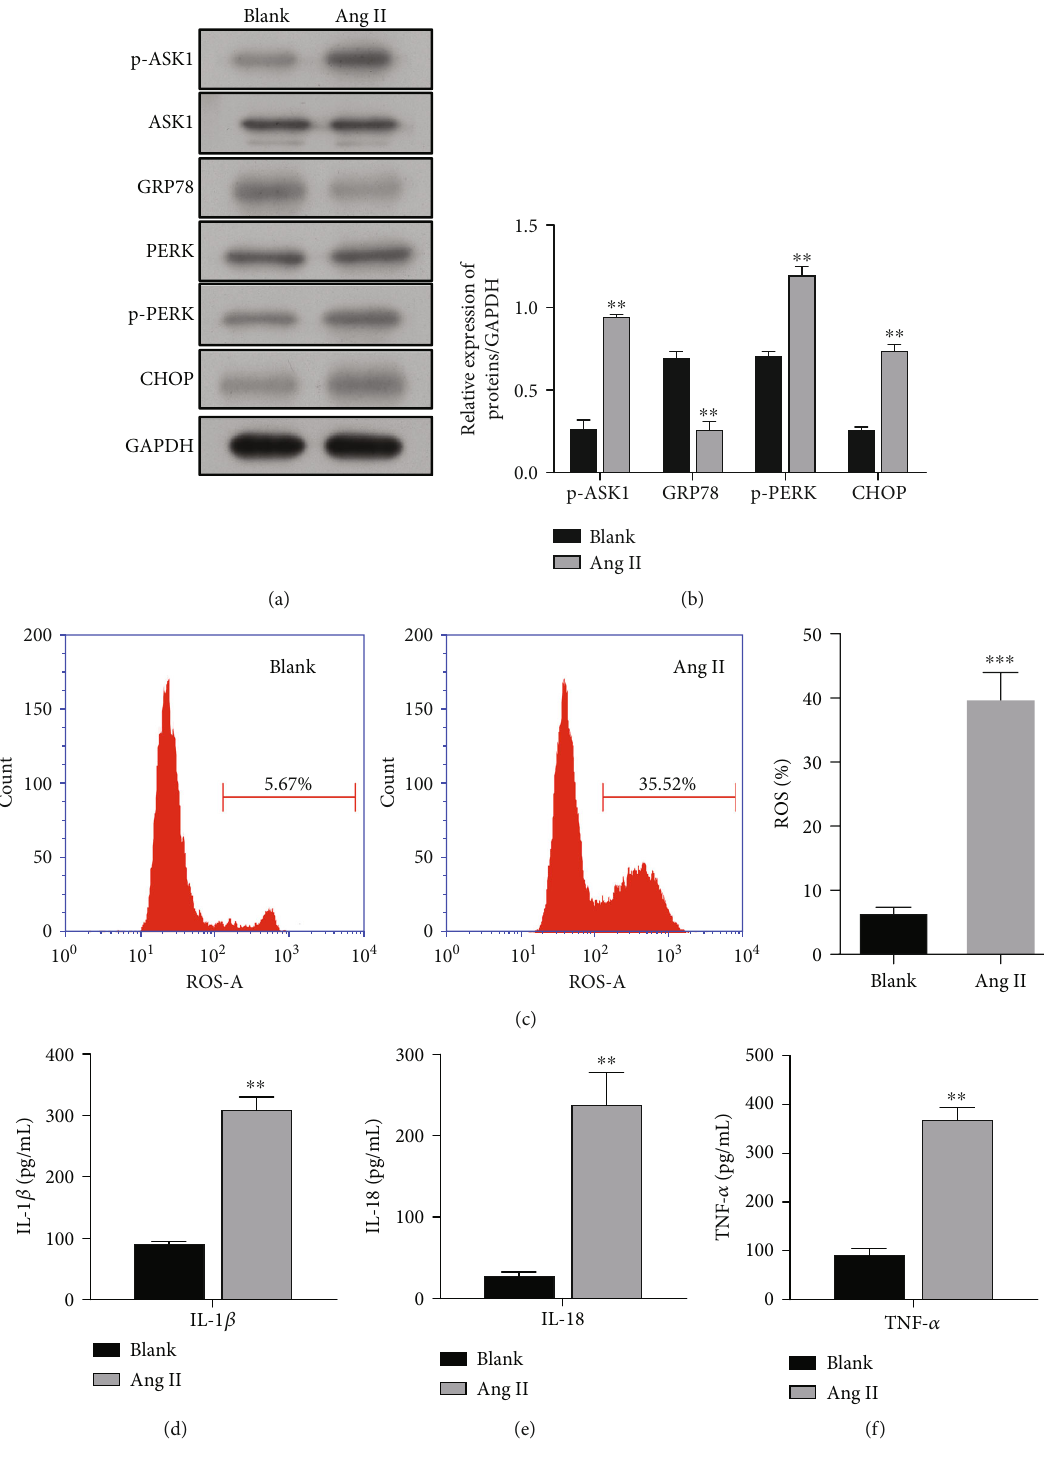
Figure 2: Expression of p-ASK1, ER stress-related proteins, and proin fl ammatory cytokines in activated HSC cells. LX-2 cells were treated with Ang II. (a) The protein bands of p-ASK1, ASK1, GRP78, PERK, p-PERK, and CHOP as well as (b) the corresponding protein levels are shown. (c) The ROS levels measured using fl ow cytometry are shown in the left panel, and quanti fi ed results for ROS generation are depicted in the right panel. ELISA methods were used to determine the expression levels of proin fl ammatory cytokines, IL-1 β (d), IL-18 (e), and TNF- α (f). Results are expressed as the mean value ± standard deviation (SD). ∗∗ p < 0 : 01 and ∗∗∗ p < 0 : 001 , compared with the blank